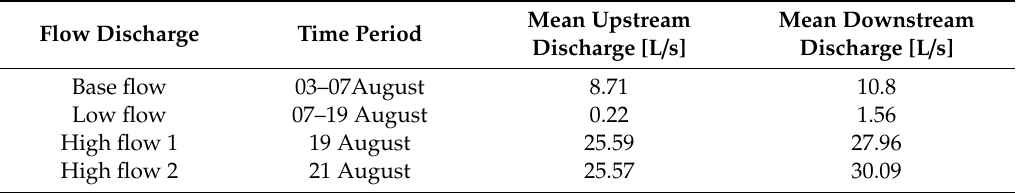
Table 2. Mean upstream and downstream stream discharge values for di ff erent flow